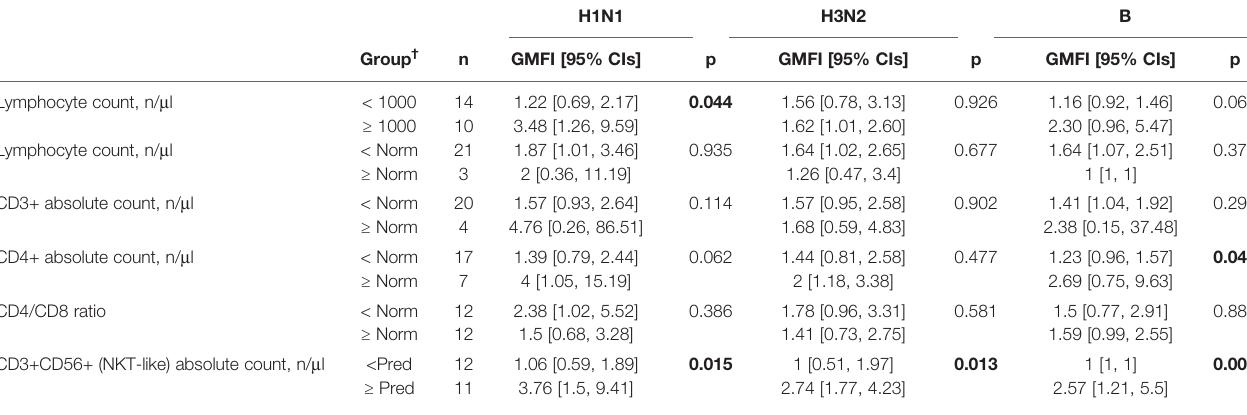
TABLE 6 | Relations between different prevaccination cellular parameters and GMFI by virus strains. Signi fi cant results are written in bold. H1N1